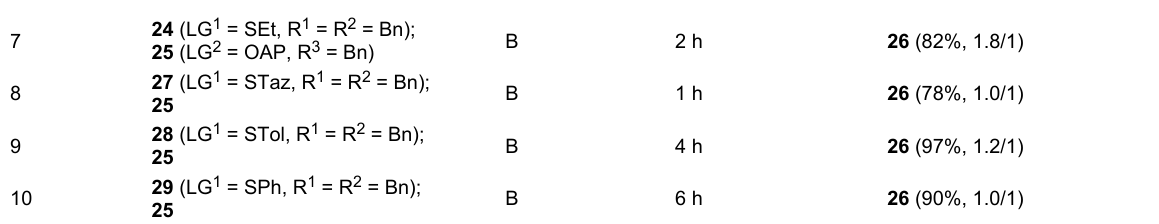
Table 2: AP glycosides as glycosyl donors and acceptors in chemoselective and selective activations. (continued)